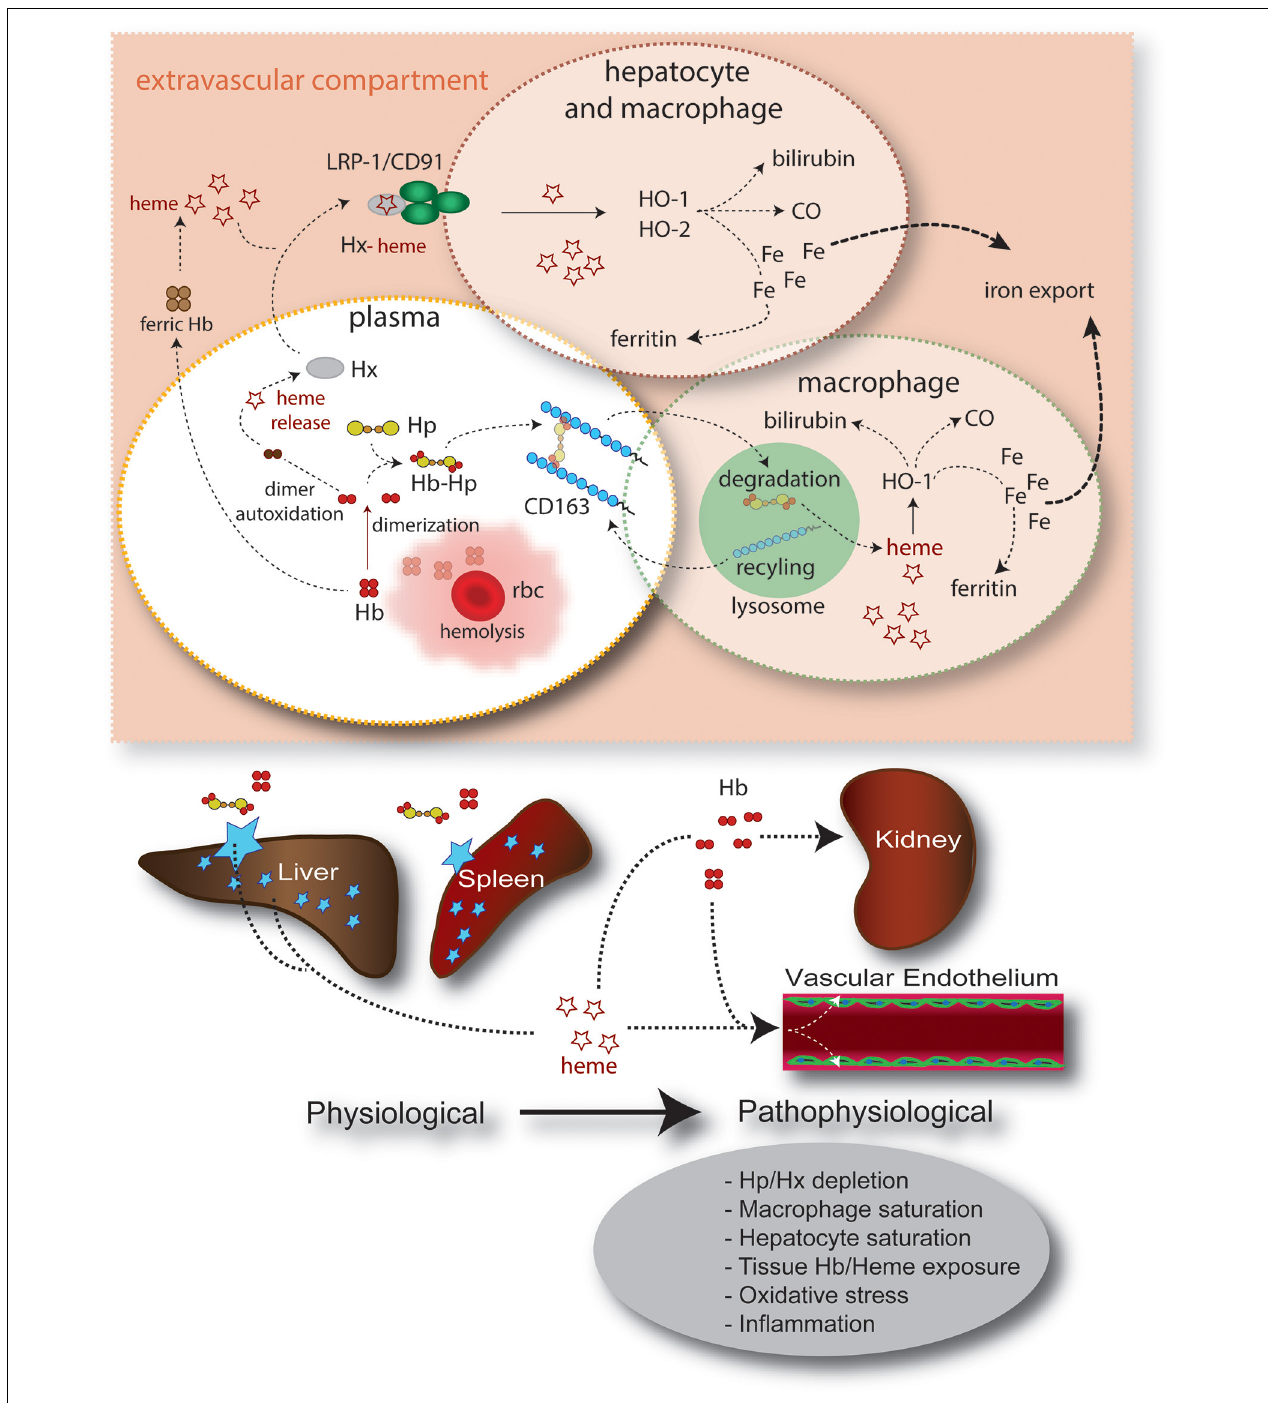
FIGURE 3 | Summary of intravascular/extravascular Hb/heme clearance and cellular/tissue distribution. The main components of the Hb/heme detoxification system are haptoglobin (Hp), which sequesters Hb in the oxidatively protected Hb-Hp complex and hemopexin (Hx). The Hb-Hp complex is cleared and metabolized by CD163 + macrophages. Alternatively, during more severe hemolysis, free heme—after release from ferric Hb—can